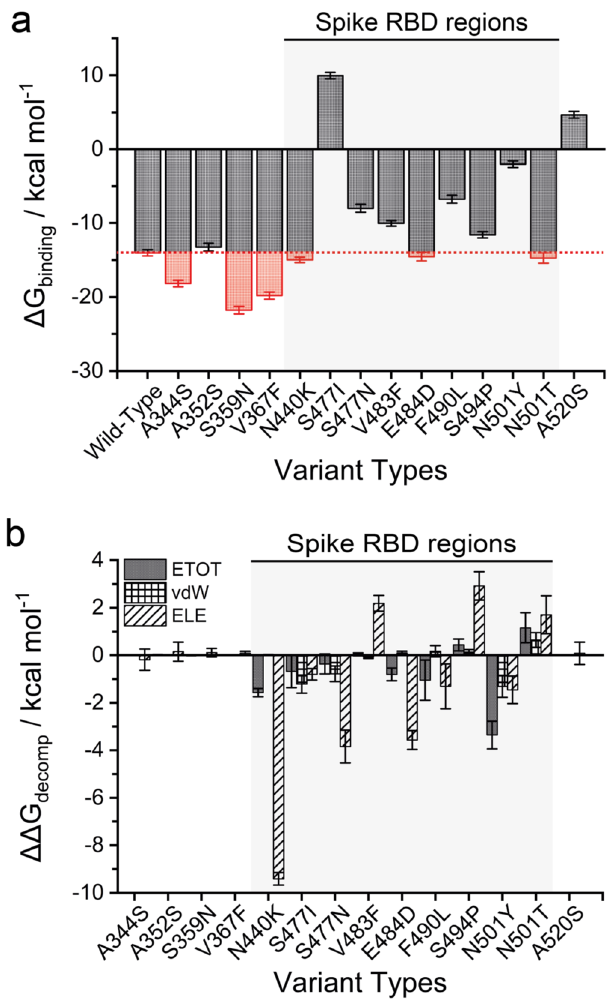
Figure 2. Binding free energies of the variant complexes estimated using MM-PBSA method. ( a ) Binding free energy (ΔG binding , kcal mol −1 ) for the interaction between SARS-CoV-2 RBD variants and ACE2 protein. The ΔG calculated for the wild-type of ACE2-spike RBD protein complex are marked in dotted line. Red bars indicate a negative ΔG value related to stronger affinity for the RBD variant binding to ACE2 than that of the wild-type model. ( b ) Per residue free energy decomposition changes (ΔΔG decomp , kcal mol −1 ) on the key residues in RBD mutants for the energy components in term of the total binding free energy (ETOT), van der Waals energy (vdW), and the sum of the electrostatic (ELE) interactions of the solvation free energy. Data are presented as mean ± SD. The p -values were calculated using single single-tailed student t -test. The p -values are shown for those with p <